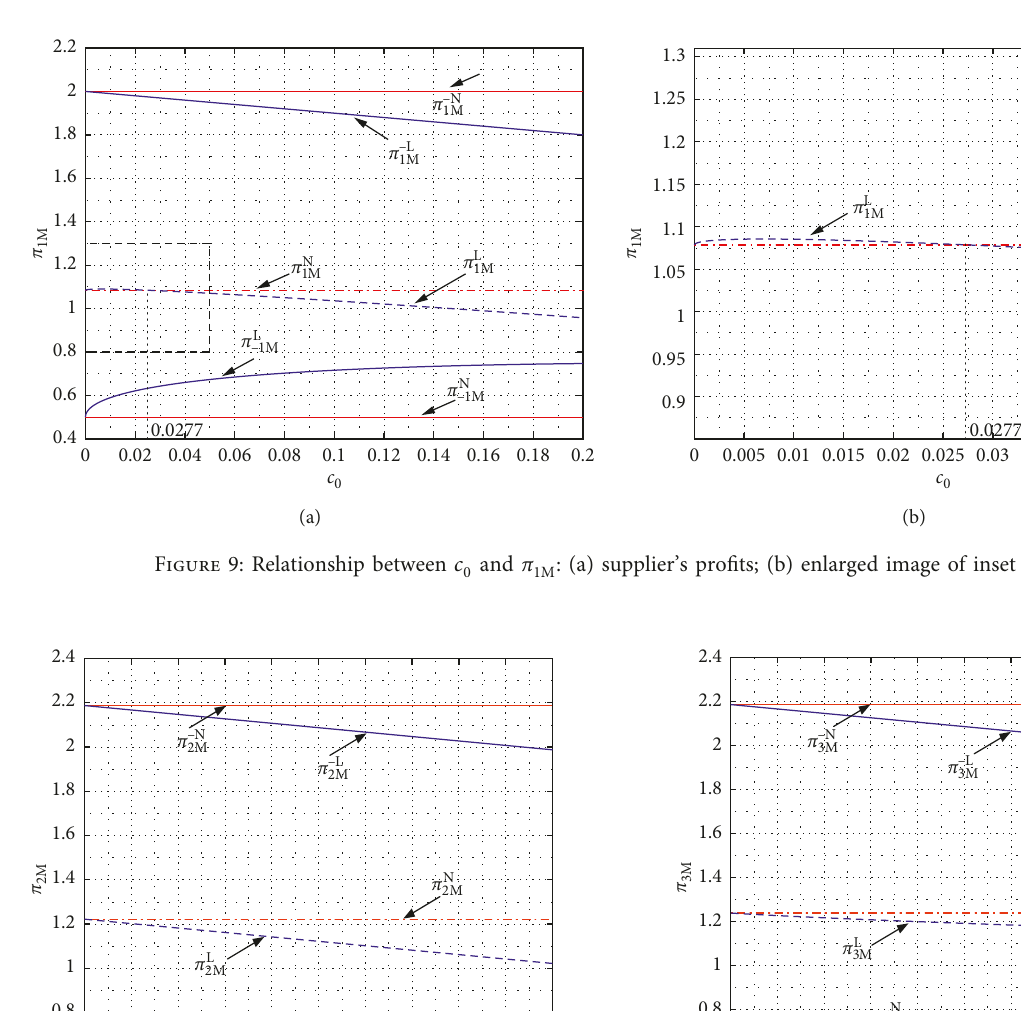
Figure 10: Relationship between c